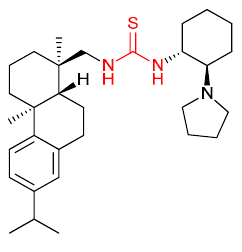
Figure 31. Rosin-derived thiourea [51].